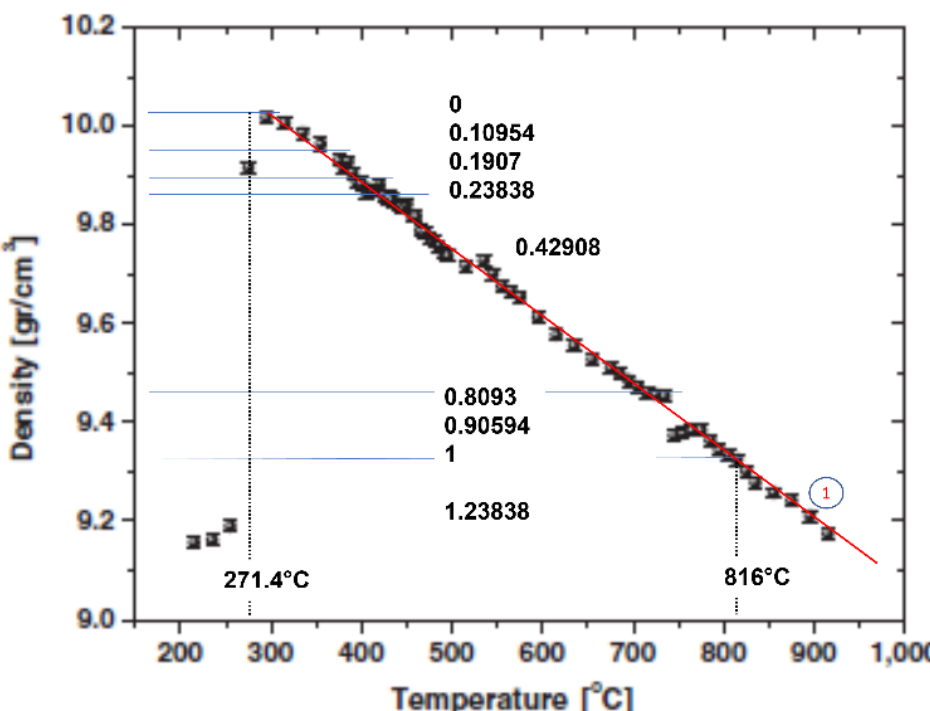
Figure 5. Bismuth density versus temperature, T (°C). Reproduced with authorization of EPL, EPI [3]. The density variation between T m (K) and 2 T m (K) is equal to the density change at T m while the enthalpy coefficient varies from 0 to 1. Singular values of the enthalpy coefficient are added to the original figure. Line (1) is the density before enthalpy relaxation of glassy phases. A melting heat, 1.23853 H m includes the latent heat of the glassy fraction occurring for T g /T m = 1 in the phase diagram of Figure 1.